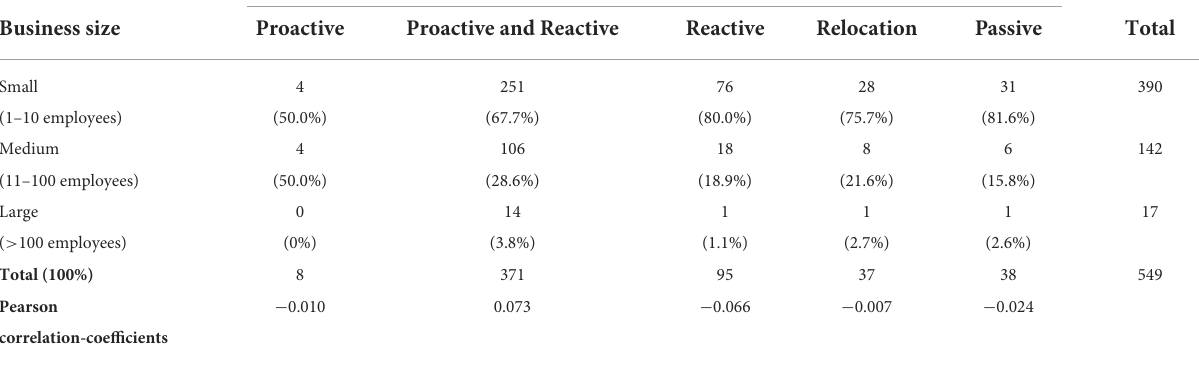
TABLE 6 Distribution of business size with class division of the number of employees and Pearson correlation coefficient without class division of the number of employees ( n = 549, data: businesses in Germany damaged by the 2013 flood). Adaptation